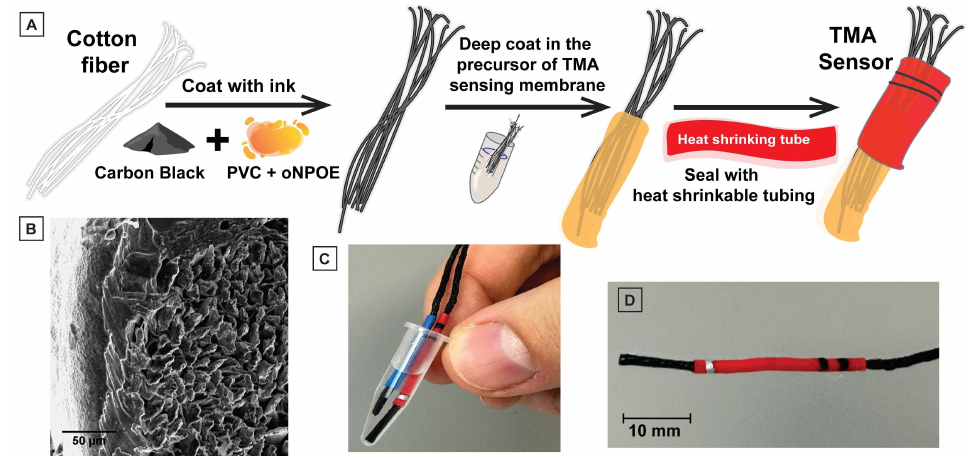
Figure 3. ( A ) The steps for fabrication of the HERS. ( B ) The SEM image of the cross section of carbon-ink- and membrane-coated TMA sensor (scale bar: 50 µm). ( C , D ) Photographs of the HERS